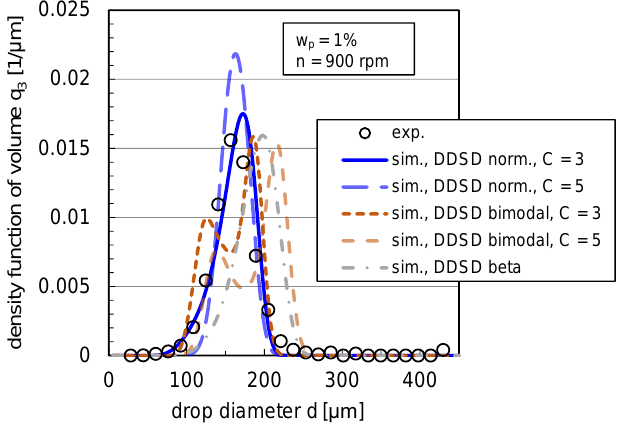
Figure 11. Impact of DDSD shape (normal, bimodal and beta distributed) and width ( C = 3 and C = 5) on volume-based density DSD q 3 for the case of binary breakage ( ν = 2). Simulations were performed with the free parameters listed in Table 1 and with the modified coalescence efficiency (Equation (12)) for w p = 1% and n = 900 rpm in comparison with the experimental distribution. Experimental and simulation results are shown in steady state ( t = 900